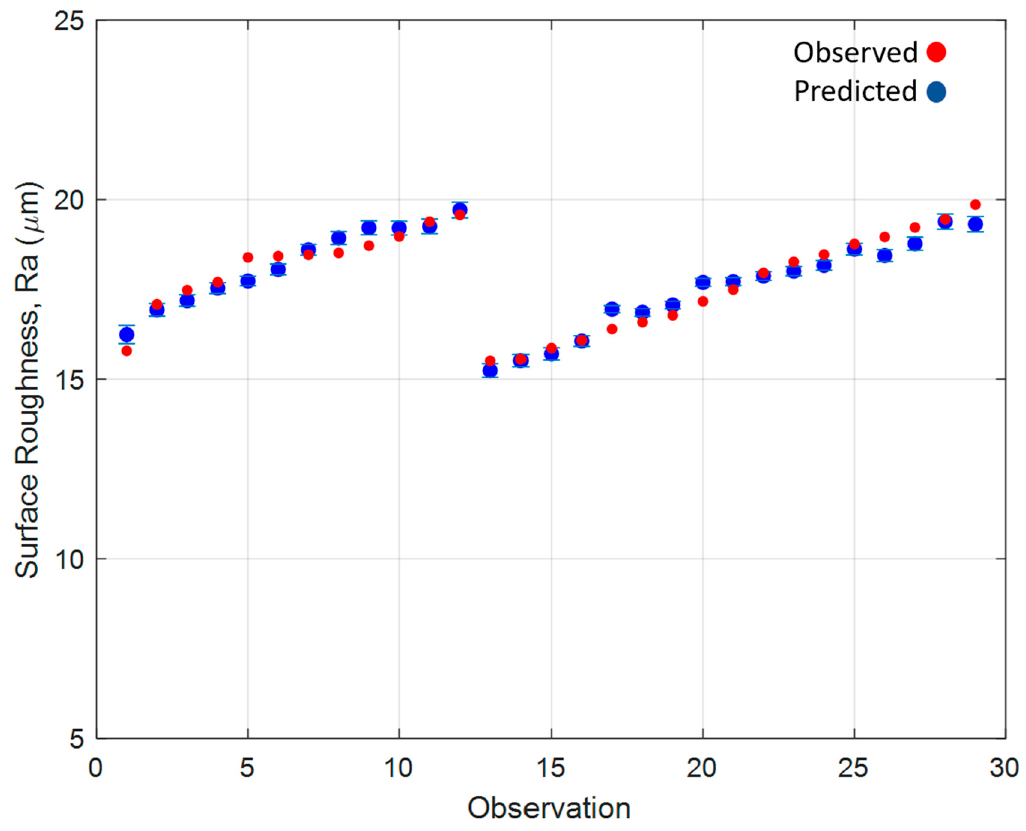
Figure 10. Surface roughness empirical model fitted values and observed values.